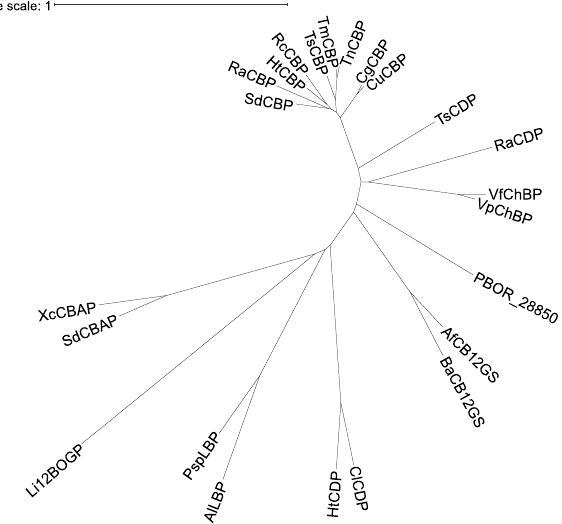
Figure 1. Phylogenetic tree of GH94 enzymes. Multiple sequence alignment was carried out by MAFFT 31 , and phylogenetic tree was constructed using Interactive Tree of Life version 5.7 (https:// itol. embl. de). SdCBP, Saccharophagus degradans CBP (ABD80580.1); RaCBP, Ruminococcus albus CBP (ADU20744.1); HtCBP, Hungateiclostridium thermocellum CBP (ABN51514.1); RcCBP, Ruminiclostridium cellulolyticum CBP (ACL76454.1); TsCBP, Thermoclostridium stercorarium CBP (AAC45510.1); TmCBP, Thermotoga maritima CBP (AAD36910.1); TnCBP, Thermotoga neapolitana CBP (AAB95491.2); CgCBP, Cellulomonas gilvus CBP (BAA28631.1); CuCBP, Cellulomonas uda CBP (AAQ20920.1); TsCDP, T. stercorarium CDP (AAC45511.1); RaCDP, R. albus CDP (ADU22883.1); VfChBP, Vibrio furnissii ChBP (AAG23740.1); VpChBP, Vibrio proteolyticus ChBP (BAC87867.1); AfCB12GS, Agrobacterium fabrum CB12GS (AAK73356.1); BaCB12GS, Brucella abortus CB12GS (ACD71661.1); ClCDP, Cellulosilyticum lentocellum CDP (ADZ85667.1); HtCDP, H. thermocellum CDP (ABN54185.1); AlLBP, Acholeplasma laidlawii LBP (ABX81345.1); PspLBP, Paenibacillus sp. YM1 LBP (BAJ10826.1); Li12BOGP, Listerila innocua 12BOGP; SdCBAP, S. degradans CBAP (ABD80168.1); XcCBAP, Xanthomonas campestris CBAP (AAM43298.1). GenBank accession numbers are shown in